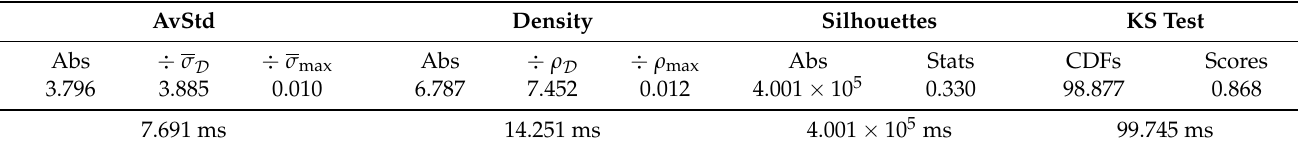
Table 6. Battery 1 execution times of the quantifiers (all values in milliseconds, ms). AvStd Density Silhouettes KS Test